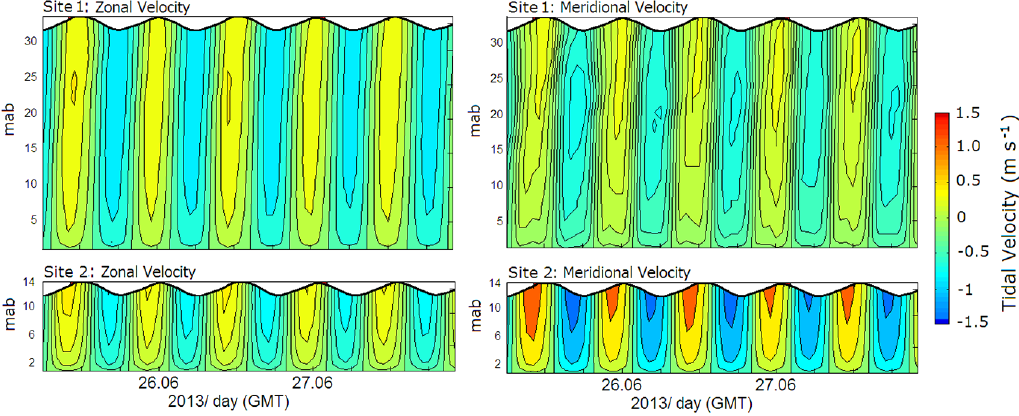
Figure 5. Time–depth variability of the sea surface height: zonal (eastward direction is positive) and meridional (northward direction is positive) tidal velocities at Site 1 (upper panels) and Site 2 (lower